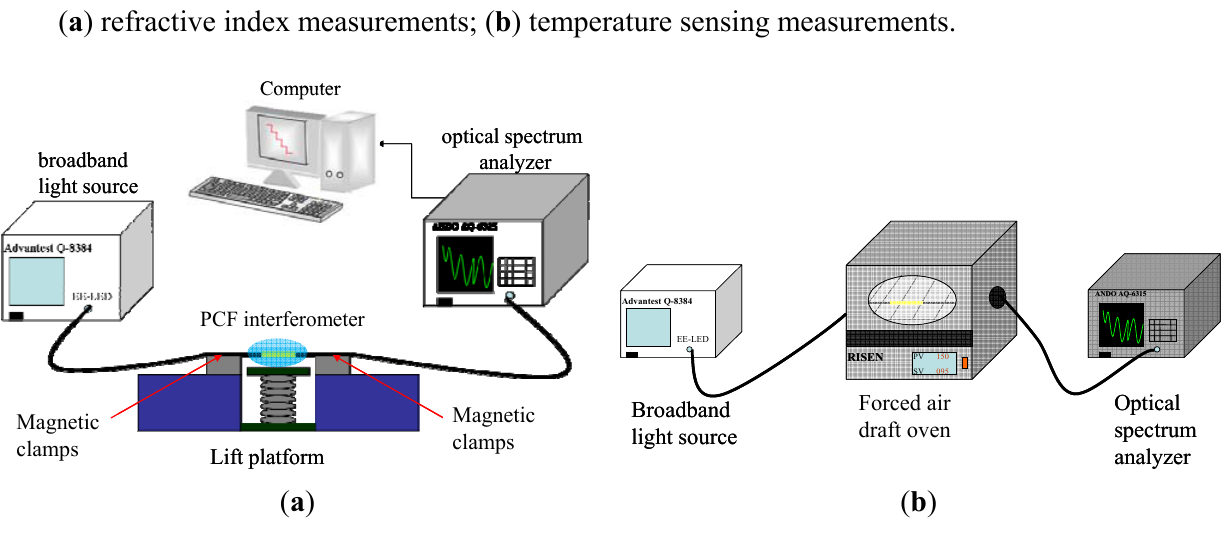
Figure 3. Schematic of the experimental setup using the PCF interferometers